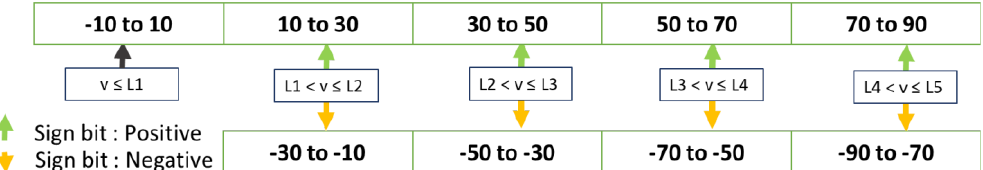
Figure 8. The bin assignment procedure.